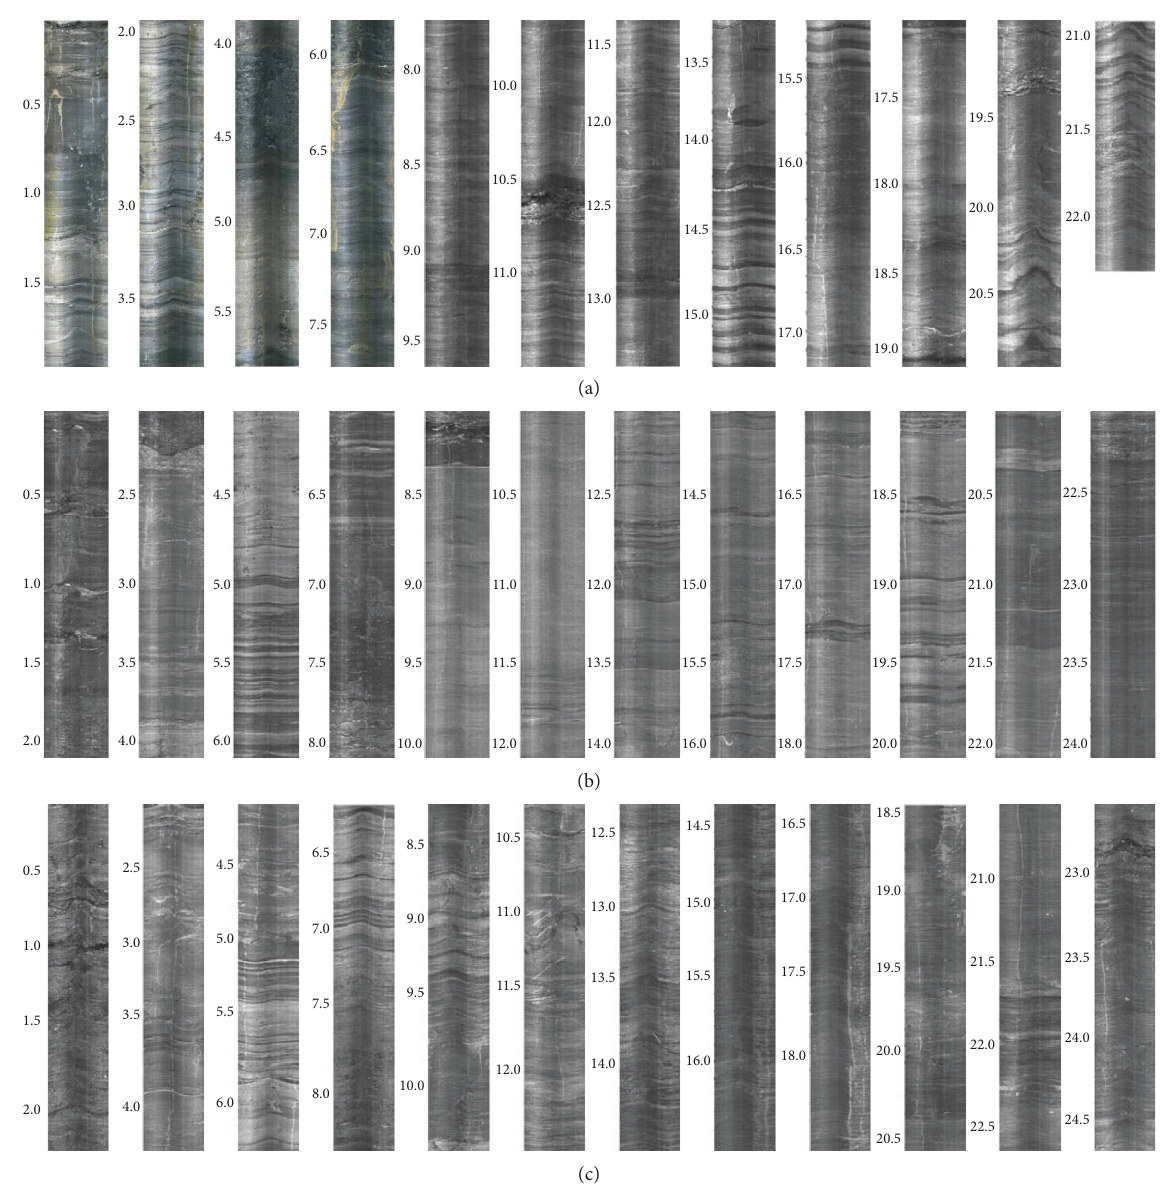
Figure 6: Structure observation of the (a) first measuring point, (b) second measuring point, and (c) third measuring Table 2: The suitable test section for stress measurement. The suitable test section Measuring points The first measuring point